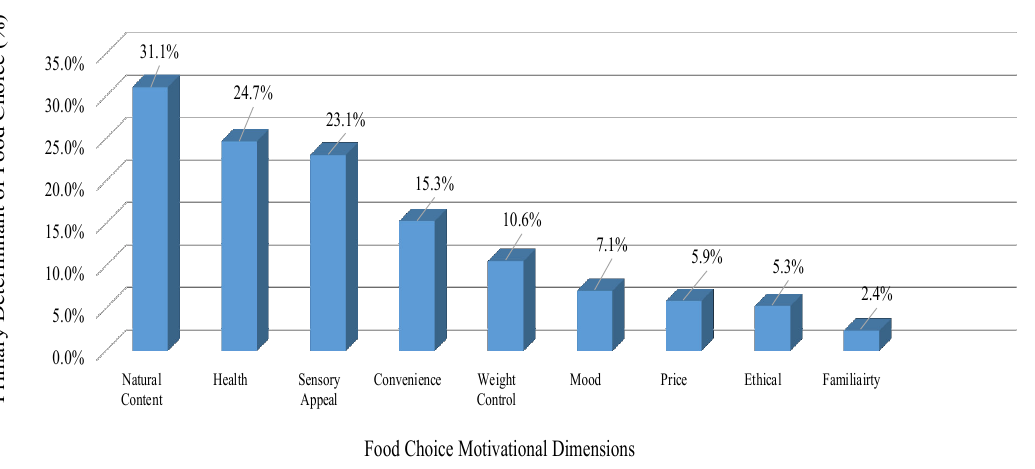
Figure 1. Primary food choice reported by the responders, in rank order.